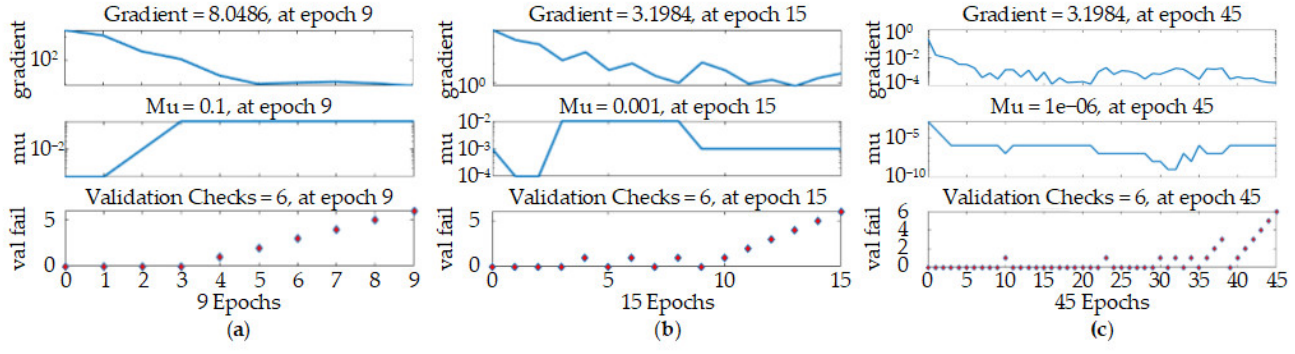
Figure 9. Model training parameter changes: ( a ) BP model; ( b ) SOM-RBF model; ( c ) RLSOM-RBF model.